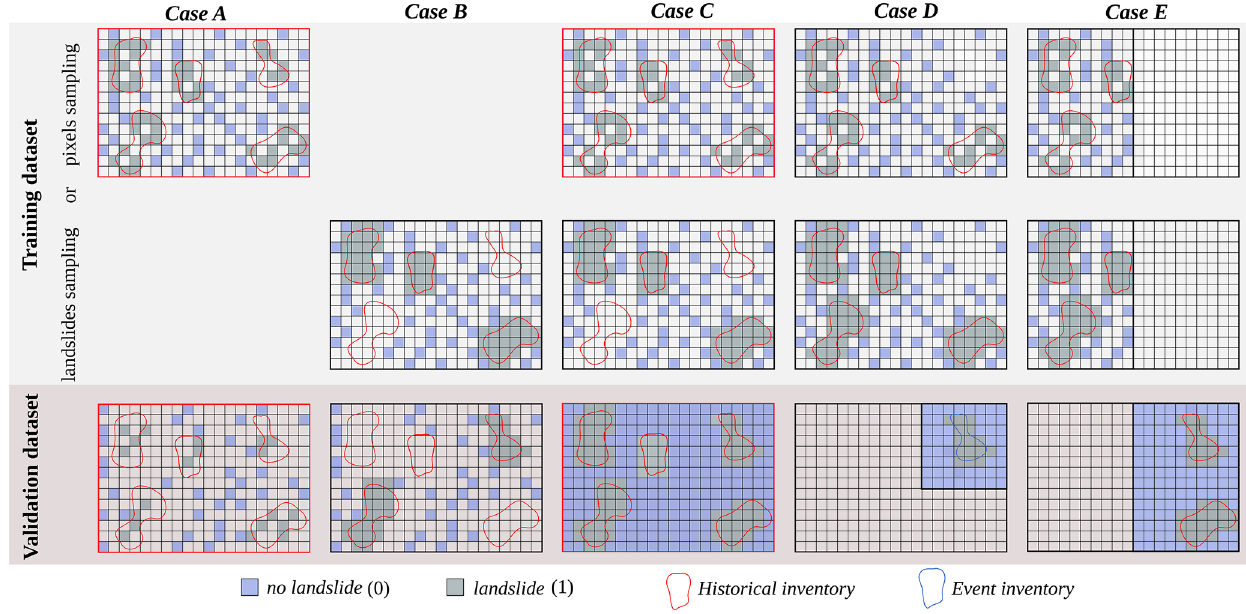
Figure 2. Simplified representations of the five LAND-SUITE applications, referred to as “cases” in the figures and text, representing common susceptibility investigations. Red boxes highlight the cases described in the application (Sect.